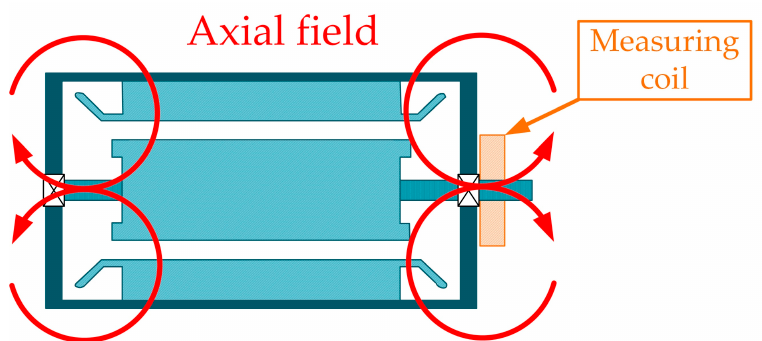
Figure 1. External stray (axial) flux in a squirrel-cage induction motor and a method of placement of an axial flux measuring coil.